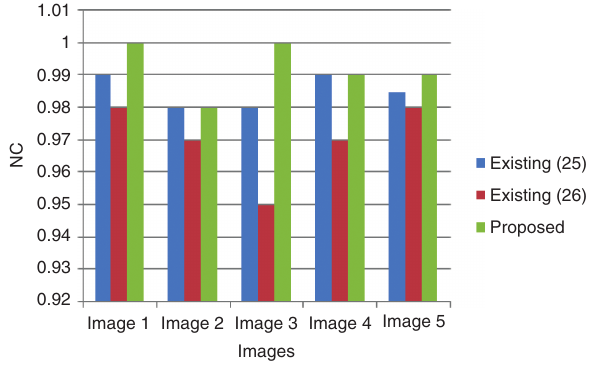
Figure 8: Comparative Analysis Based on NC